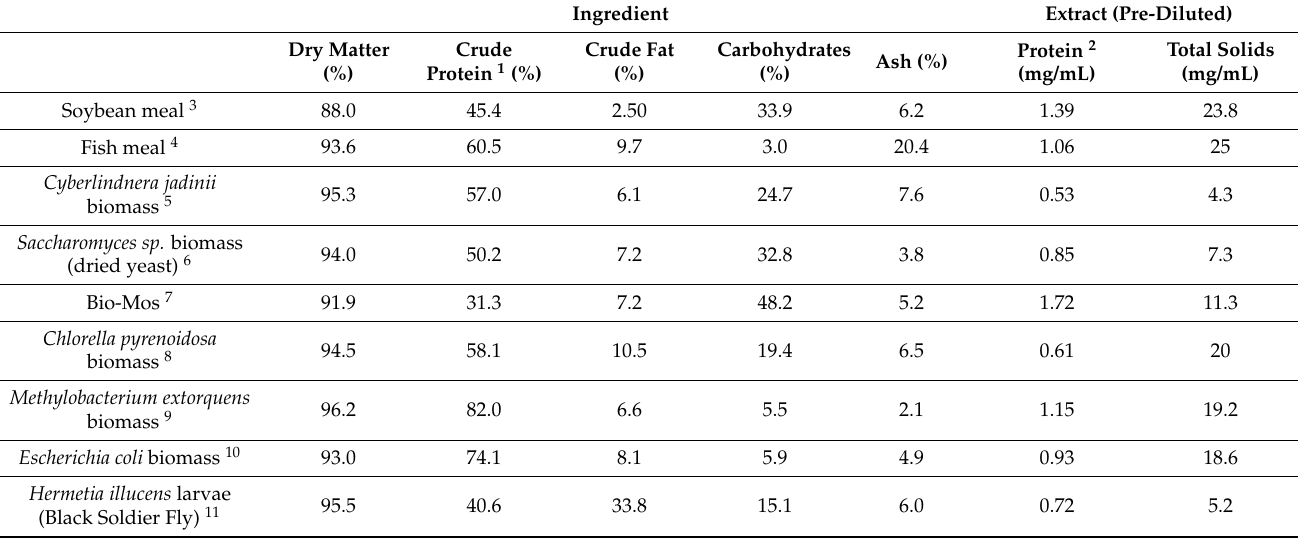
Table 1. Proximate composition of traditional and alternative protein products and aqueous